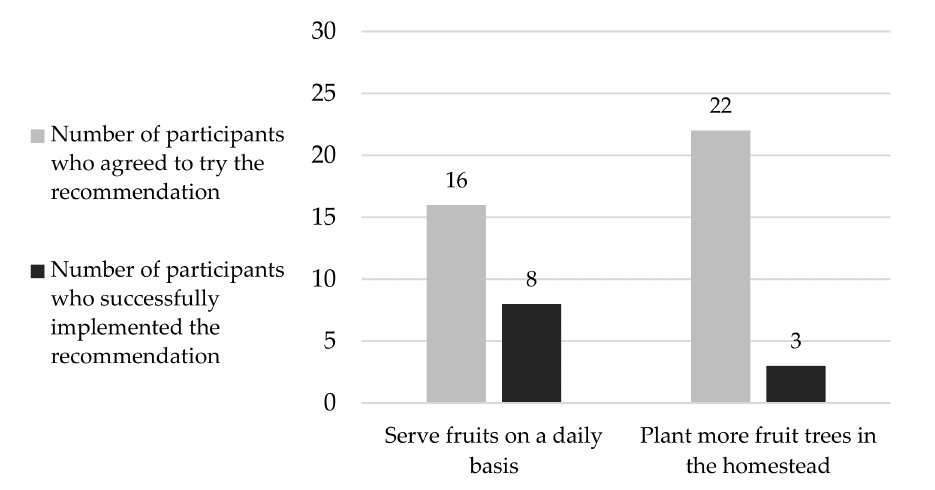
Figure 4. Numbers and implementation rates of the recommendations on fruit consumption tested during the TIPs (N = 48); TIPs = Trials of Improved